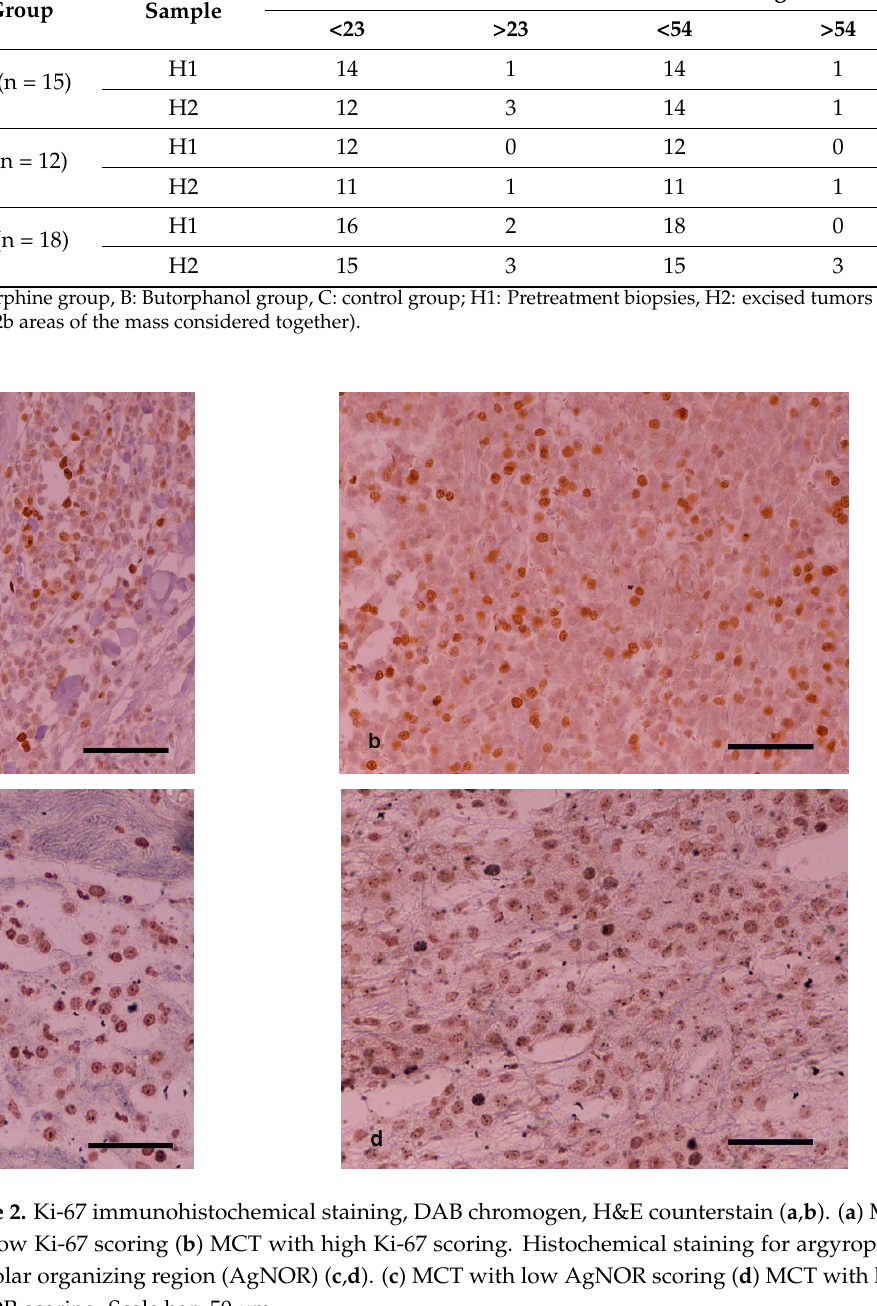
Table 5. Classification based on Ki-67 and Ki-67 × AgNOR scorings allocated in H1 and H2 samples, (predefined cutoff values of 23 and 54, respectively).